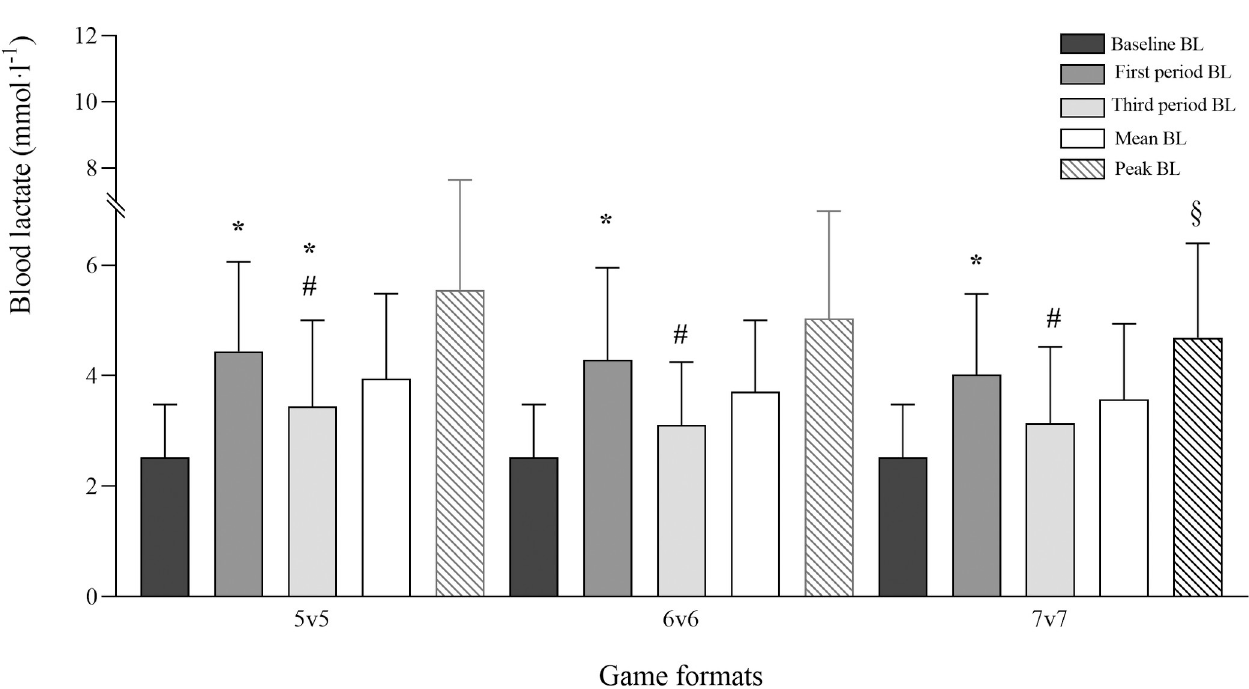
Fig 3. Baseline (dark grey bars), first period (medium grey bars), third period (light grey bars) mean blood lactate and match mean (white bars) and peak (listed bars) blood lactate levels during 5v5, 6v6 and 7v7 recreational team handball game formats (data are presented as means ± SD). BL–Blood lactate. � Significantly different from baseline; # significantly different from the first period and § significantly different from 5v5 ( p < 0.05).